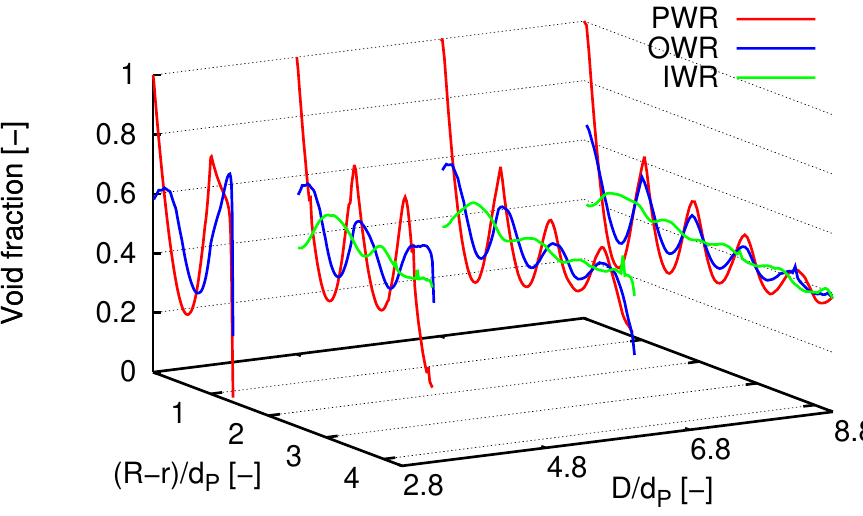
Figure 12. Radial void fraction